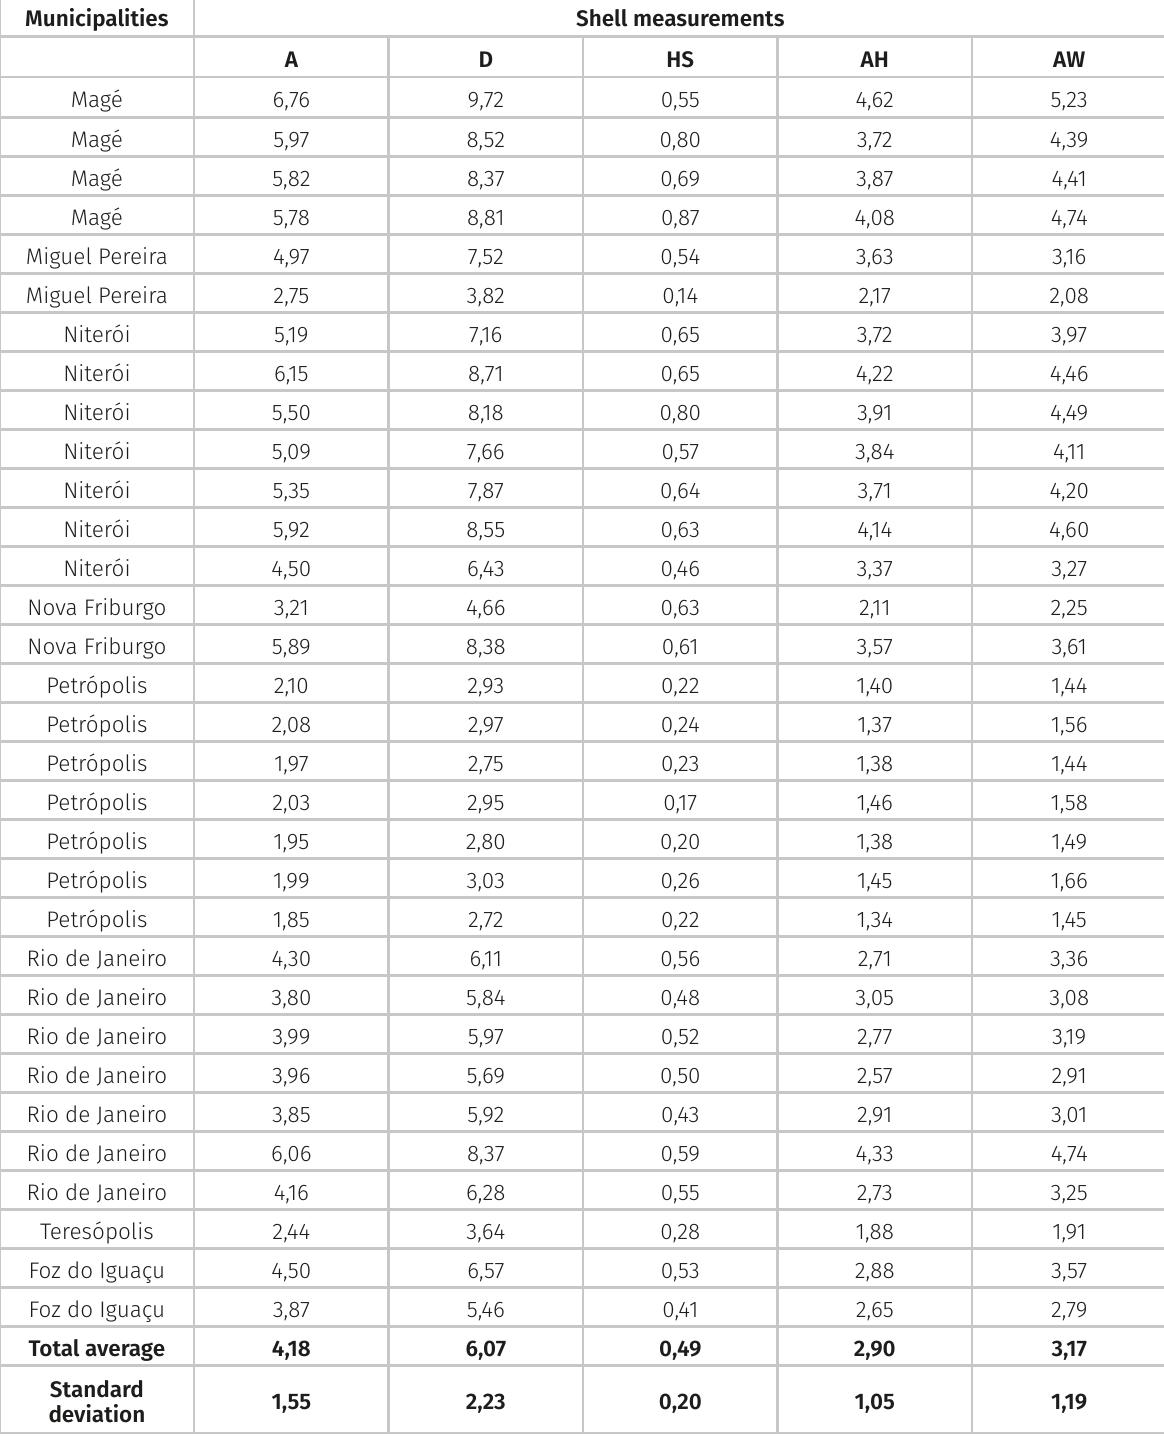
Table II. Shell measurements obtained under a stereomicroscope with image capture system, using Leica Application Suite program (v 4.8). A. Shell height; D. Shell width; HS. Spire height; AH. Aperture height; AW. width of